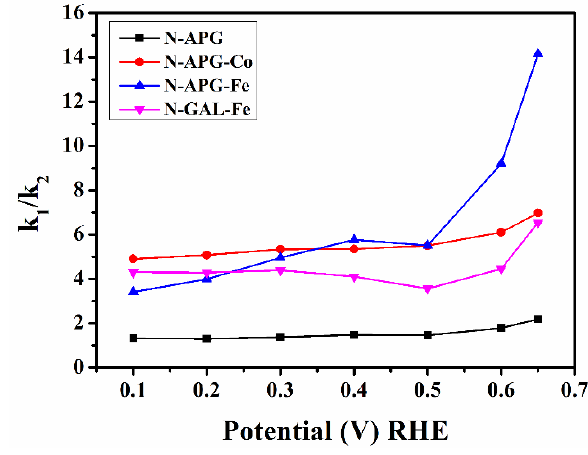
Figure 5. The ratio of rate constant k1/k2 for, N-APG, N-APG-Fe, N-APG-CO and N-GAL-Fe in the potential range of 0.10–0.65V.